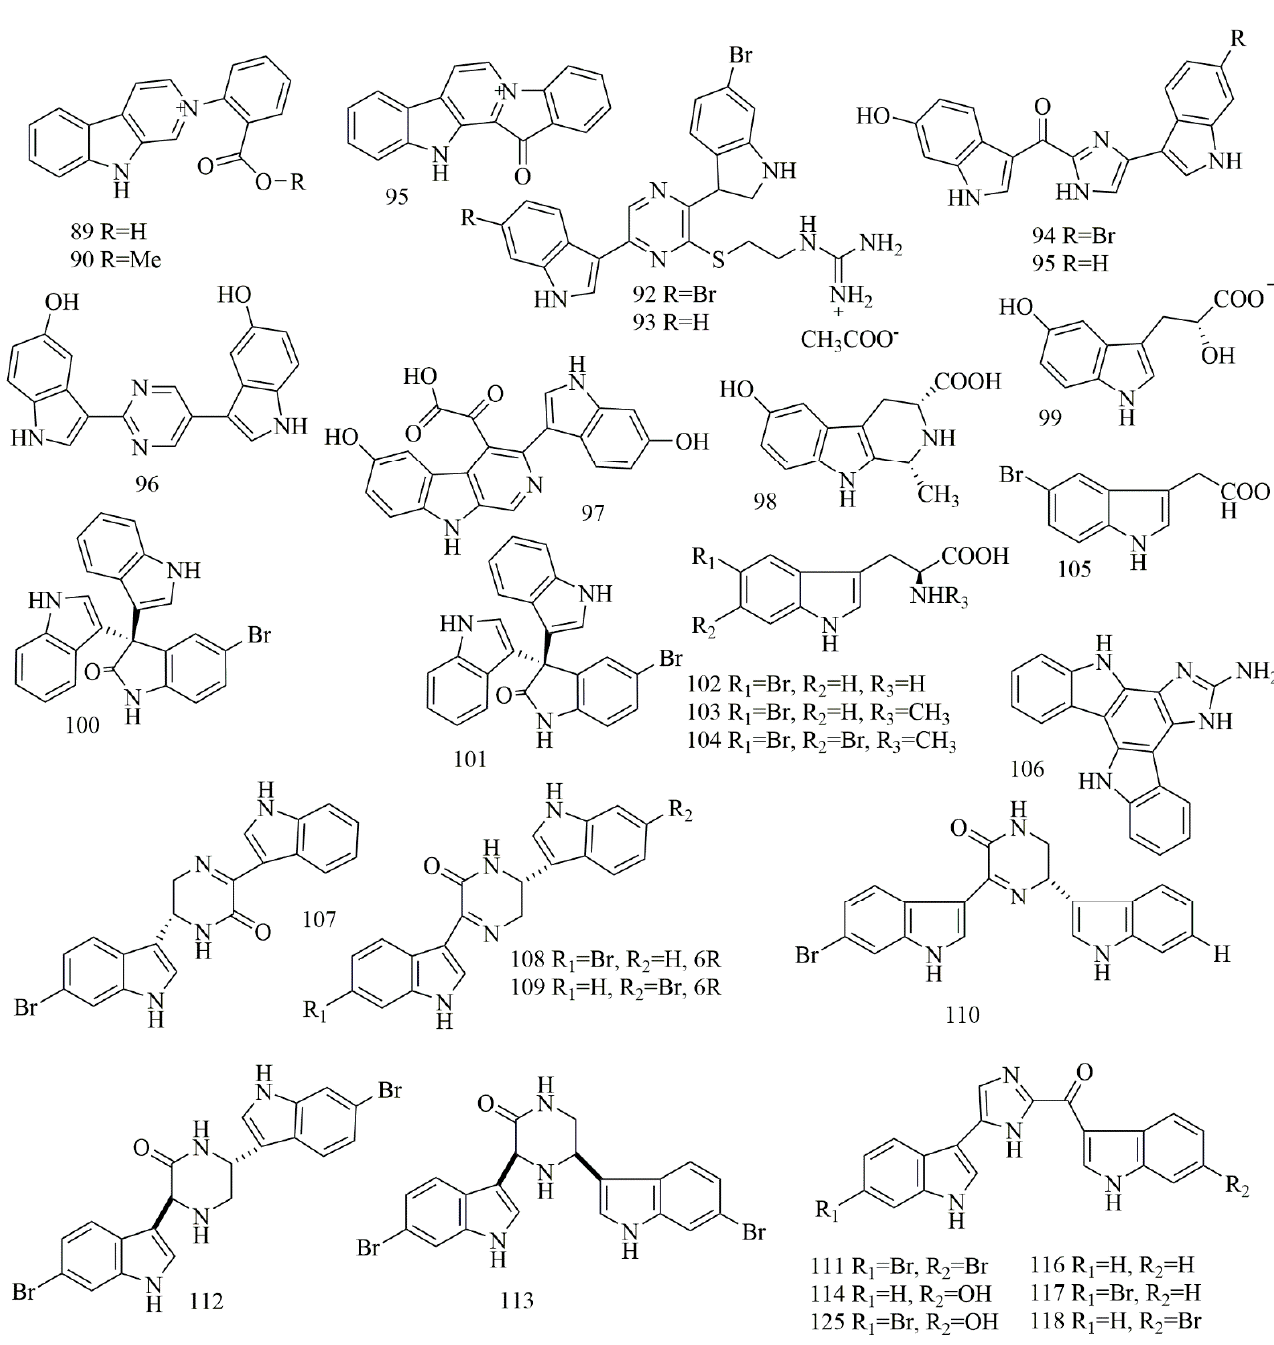
Figure 8. Cytotoxic Indol, Bisindol, and Trisindol alkaloid structures in marine sponges. Table 8. Cytotoxic activity of Indol, Bisindol, and Trisindol alkaloids.